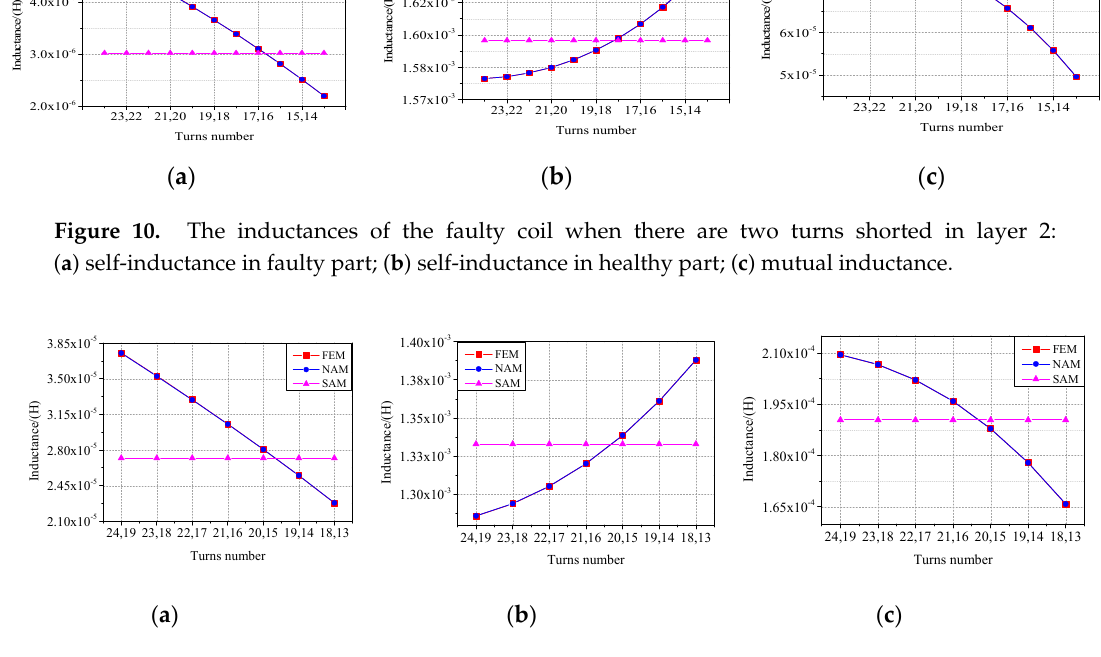
Figure 11. The inductances of the faulty coil when there are six turns shorted in layer 2: ( a ) self-inductance in faulty part; ( b ) self-inductance in healthy part; ( c ) mutual inductance.